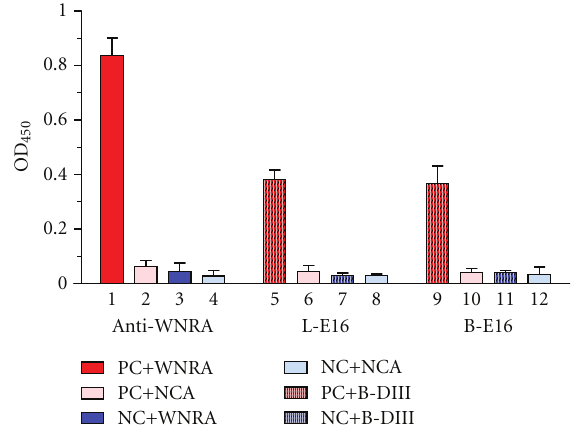
Figure 6: WNV IgM capture ELISA with plant-derived DIII antigen and E16 mAbs. Columns 1 and 2 (positive controls): WNV IgM-positive serum (PC) detected by kit-supplied positive control antigen WNRA (1) or negative control antigen NCA (2) with the kit-supplied WNRA-specific antibody (Anti-WNRA); Columns 3 and 4 (negative controls): WNV IgM negative serum (NC) detected by WNRA (3) or NCA (4) with Anti-WNRA; Columns 5 and 6: PC detected by N. benthamiana -derived DIII antigen (B-DIII) (5) or NCA (6) with lettuce-derived E16 (L-E16); Columns 7 and 8: NC detected by B-DIII (7) or NCA (8) with L-E16; Columns 9 and 10: PC detected by B-DIII (9) or NCA (10) with N. benthamiana - derived E16 (B-E16); Columns 11 and 12: NC detected by B-DIII (11) or NCA (12) with